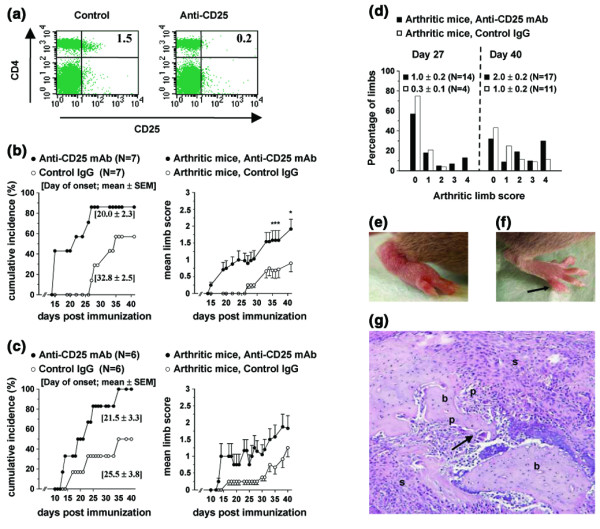
Wild-type mice treated with anti-CD25 antibodies develop a more severe form of arthritis. In three experiments, wild-type DBA/1 mice were immunised on day 0 with collagen type II in complete Freund's adjuvant. From day 11 (c) or 13 (b) after immunisation onwards, mice were treated every second day with 0.25 mg of depleting anti-CD25 monoclonal antibody (N = 7) or with 0.25 mg control rat IgG (N = 7). (a) Depletion of the CD25+ cell population was checked in the blood twice a week by flow-cytometric analysis with anti-CD4 and anti-CD25 antibodies. A representative staining pattern on day 27 is shown. The percentages of CD4+CD25+ cells in control-treated mice (left plot) and anti-CD25-treated mice (right plot) are shown. (b, c) Cumulative incidence of arthritis (and mean day of disease onset) and the mean limb score of the arthritic mice in female (b) and male (c) wild-type mice treated with anti-CD25 or control IgG are shown (the maximum score per limb is 4). Error bars indicate SEM. The data from the female mice are representative of two independent experiments. The data of the three experiments were pooled and the percentage of limbs with each limb score on days 27 and 40 after immunisation is shown in (d). The mean limb score of the arthritic mice in the two groups is also indicated for the two time points and is significantly higher in the treated mice (P < 0.05; Mann–Whitney U-test) than in those receiving control IgG. (e, f) Representative pictures of the most severe case of collagen-induced arthritis on day 25 after immunisation of a mouse treated with anti-CD25 (e) and a mouse treated with control IgG (f). (g) Haematoxylin-stained paraffin section of the joint of an anti-CD25-treated mouse on day 42 after immunisation. Hyperplasia and infiltration of immunocompetent cells in the synovium (s) and pannus formation (p) that penetrates into the bone (b) can be seen. Note the presence of osteoclast-like multinucleated giant cells (arrow). *P < 0.05 for comparison with control IgG1-treated mice (Mann–Whitney U-test).